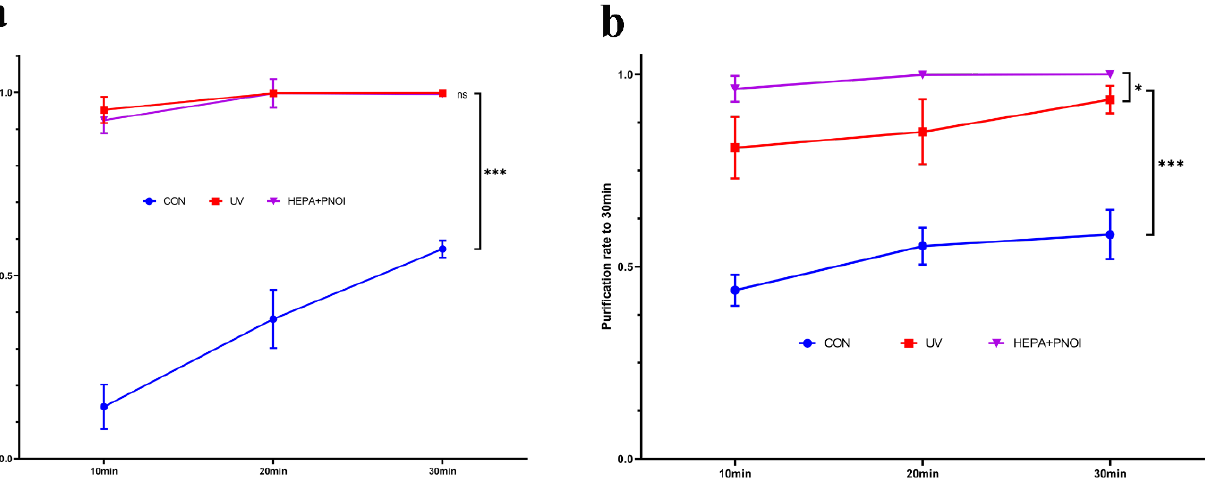
Figure 4. Comparison of the efficacy of purifier combination and UV lamps in removing S. albus ( a ) and influenza virus ( b ). The statistical differences between the items are analyzed. (ns: no significance; *: p < 0.05; ***: p < 0.001).